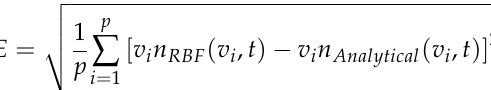
Figure 1. Comparison of the RBF method and the analytical solution for predicting the temporal evolution of particle size distributions: ( a ) constant kernel coagulation; ( b ) sum kernel coagulation. The solid lines are predictions obtained using the analytical solutions and the plus symbols are pre- dictions obtained using the RBF method.